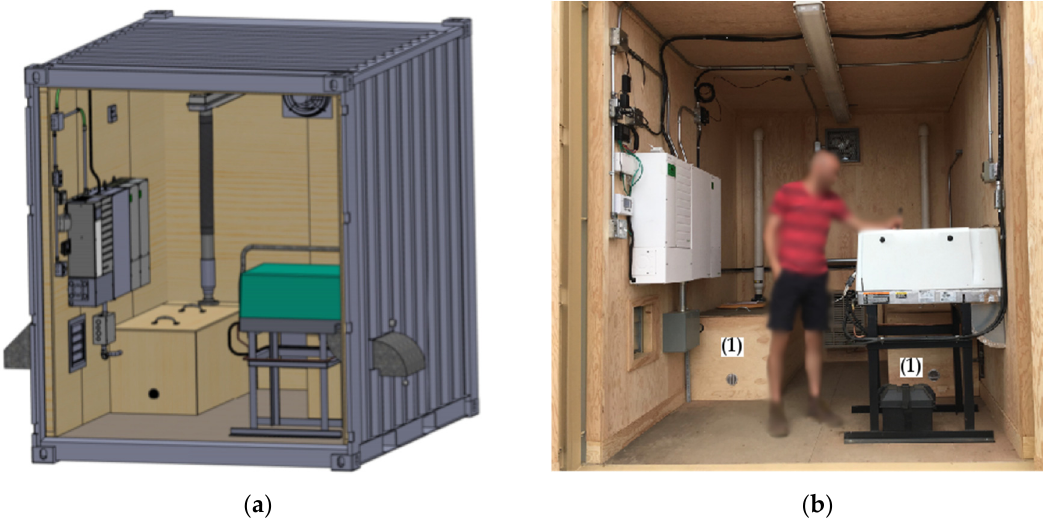
Figure 1. ( a ) Computer aided design (CAD) model of the 10’ ISO container-based PV-genset-battery hybrid system. ( b ) As built container-based system in the field. Twelve 2 V 1000 Ah flooded lead-acid cells are in each of the battery boxes (1) to form a 48 V 1000 Ah battery bank. Table 1. As-designed DC-coupled photovoltaic (PV) hybrid system dimensioning Design